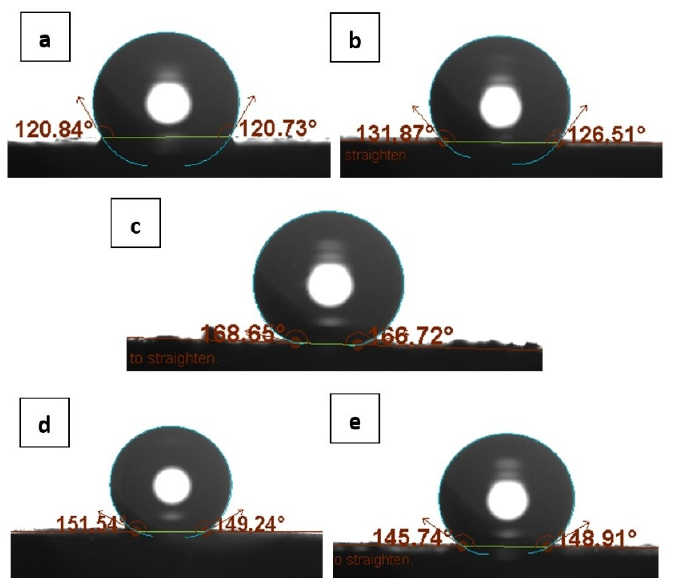
Figure 2. Contact angles of tested layers: ( a ) eCNF, ( b ) eCNF-Co, ( c ) eCNF/CNT[HD]-Co, ( d ) eCNF/CNT[HD]-NiCo, ( e ) eCNF/CNT[LD]-NiCo.